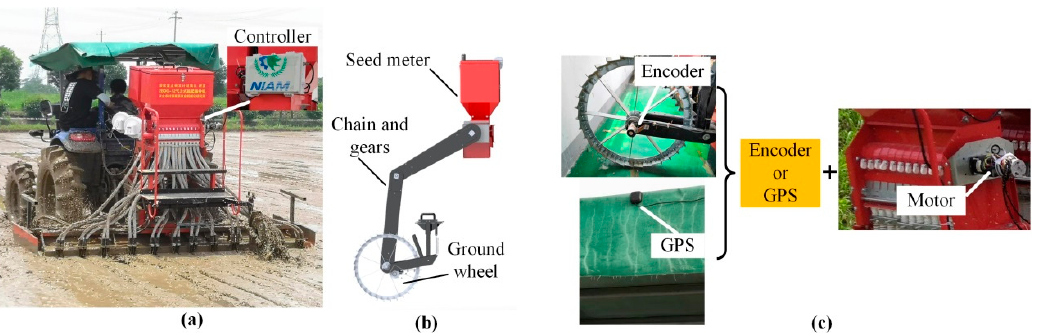
Figure 1. The seeder and its driving system for field tests. ( a ) the seeder; ( b ) The mechanical driving system with chains and gears; ( c ) The electric drive system consists of a motor to drive the seed meter and the encoder or GPS to measure the travel